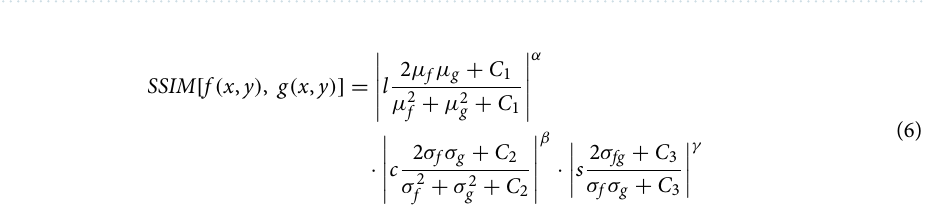
Figure 4. Output maps of different concentrations of NO 2 (collected by dual-band light) ( a ) N 2 , ( b ) 0.6%, ( c ) 0.8%, ( d )